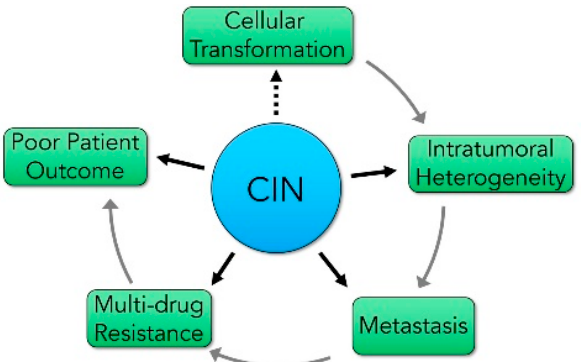
Figure 1. The impact of chromosome instability (CIN) on key features of cancer development, progression, and outcomes. A schematic depicting the central impact CIN has on early tumorigenic events (cellular transformation), tumor evolution (intratumoral heterogeneity), disease progression (metastasis), and the development of chemoresistance (multi-drug resistance), all of which are often associated with poor patient outcomes. Dotted lines identify proposed relationships, while solid lines identify established relationships.